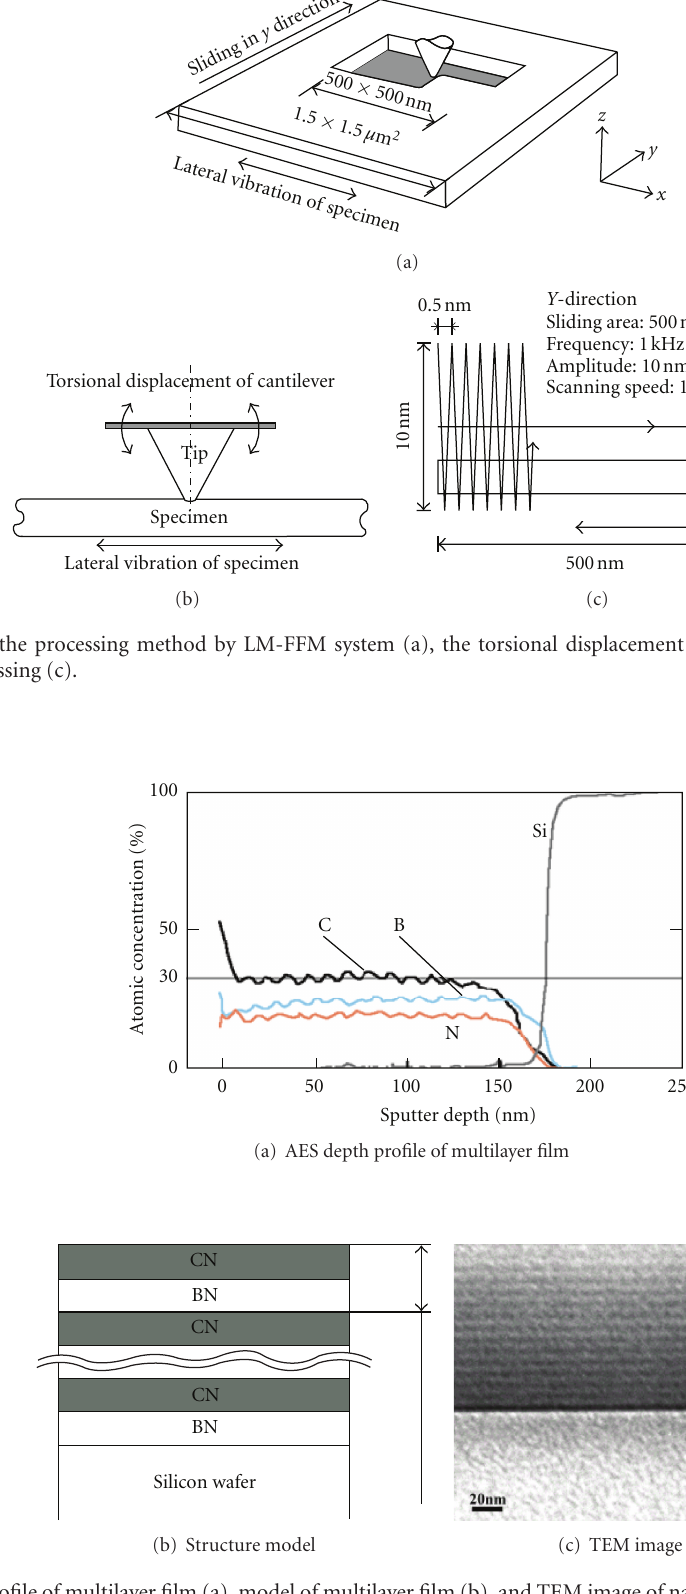
Figure 4: AES depth profile of multilayer film (a), model of multilayer film (b), and TEM image of nanoperiod multilayer film with a period of 8nm